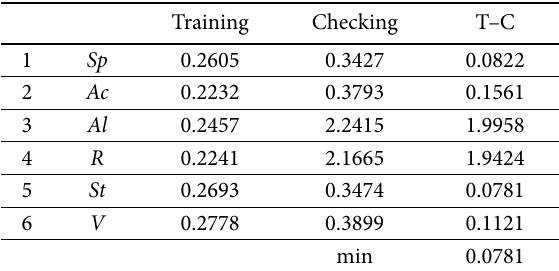
Table 1. Training and checking errors with an input at a time